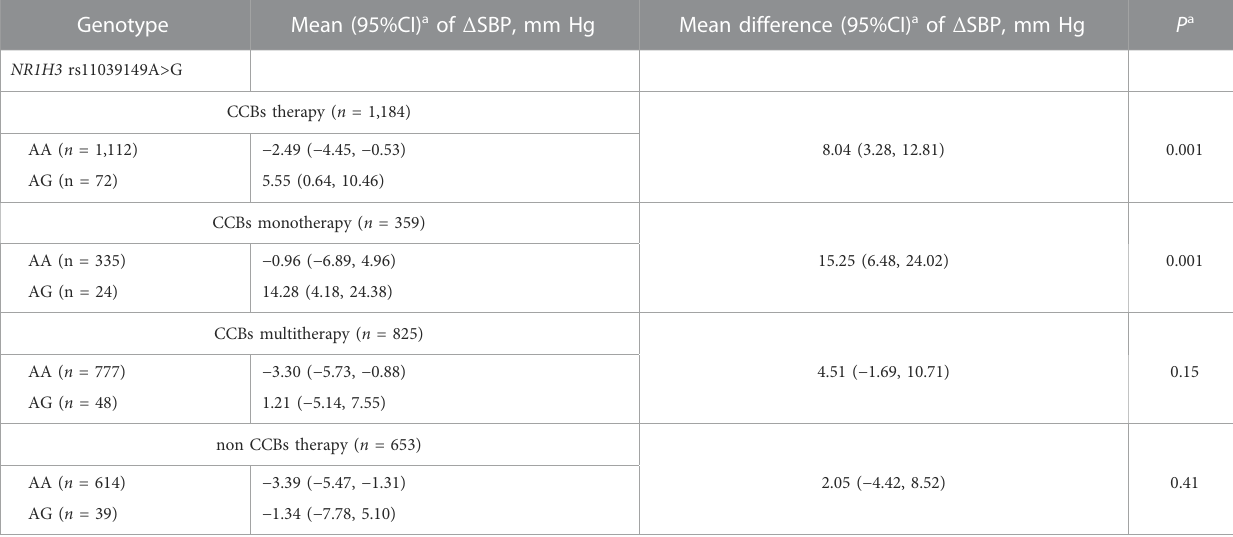
TABLE 3 Effects of NR1H3 variant rs11039149A > G on SBP response to CCBs therapy. Genotype